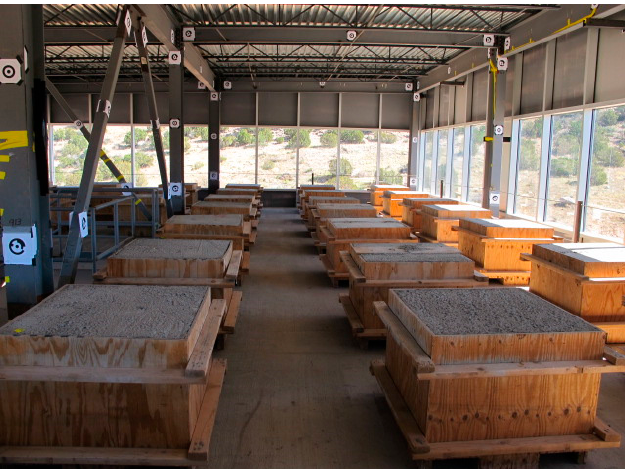
Figure 11. View of the concrete blocks for approximating loads under operational conditions con- sistent with extraordinary load combination of ASCE/SEI 7-10 [20] (45 per floor, 90 total on 2nd & 3rd floors).